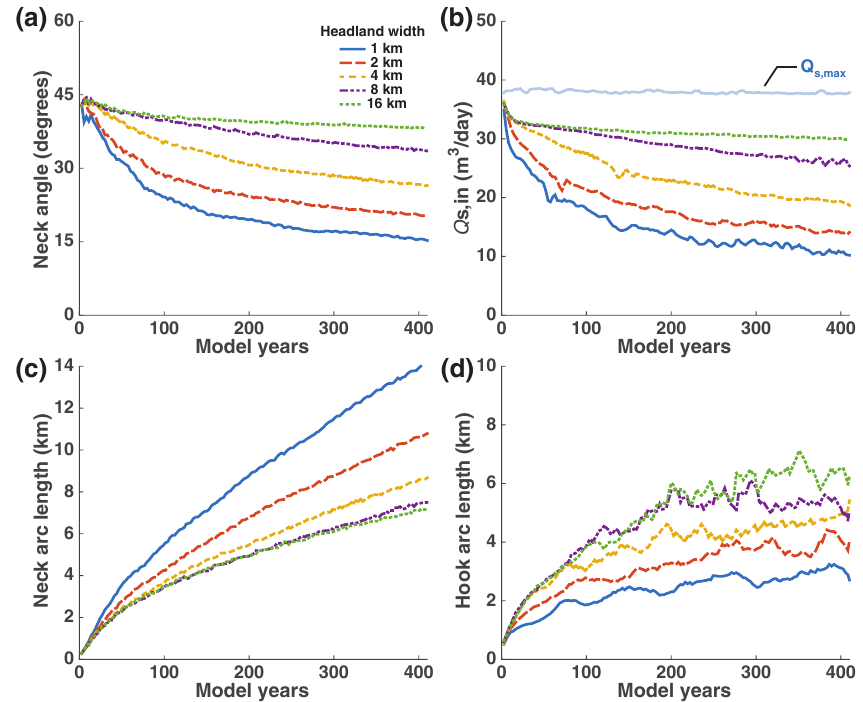
Figure 8. Characteristics of spits growing from a symmetrical wave climate ( A = 0 . 5 , U = 0 . 2) with different initial widths, showing change in time of (a) the neck angle (defined as the line from the locations of Q s,in to Q s,max ), (b) the alongshore flux into the spit at Q s,in , (c) neck arc length, and (d) hook arc length.